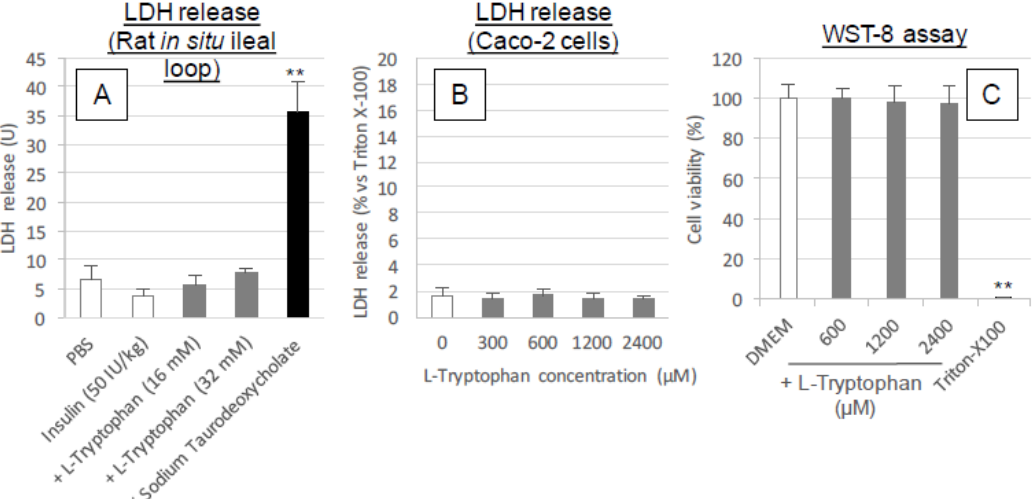
Figure 5. Cytotoxicity examinations after the exposure of intestinal epithelium to L -tryptophan. Panel ( A ), the LDH release in the intestinal fluid collected at 60 min after ileal administration of PBS, insulin (50 IU/kg) with or without L -tryptophan (16–50 mM) and sodium taurodeoxycholate (5%). Panel ( B ), LDH released from the cytoplasm into the incubation medium (HBSS) after incubation with various concentrations of L -tryptophan (200–2400 µ M). The value is expressed as a percentage calculated by dividing the absorbance of the L -tryptophan treated medium sample by that of the sample treated with Triton X-100 (0.8%). Panel C, cell viability after incubation with various concentrations of L -tryptophan (600–2400 µ M). Each data point represents the mean ± SEM of N = 3, 3 and 6–11 for panels ( A – C ), respectively. * p < 0.05, ** p < 0.01, significantly different with corresponding control PBS- (panel ( A )), or DMEM- (panel ( C )) treatment group.